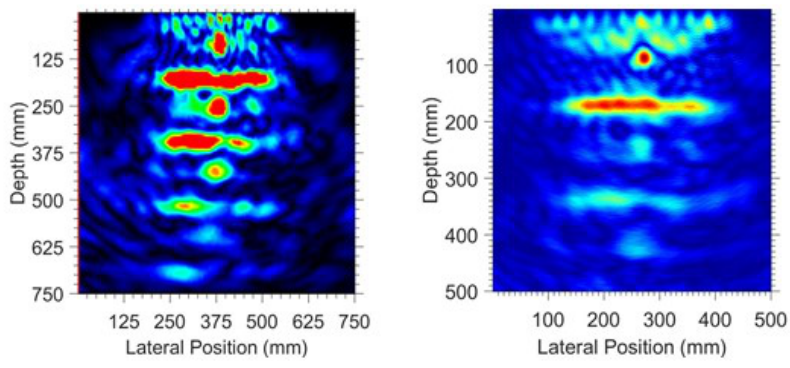
Figure 6. Standard (left) and evaluated (right) images of a CS’ point over the 94 mm-deep dowel.